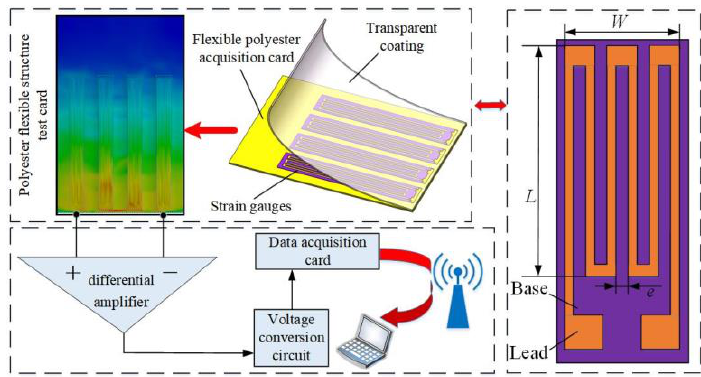
Figure 1. Schematic diagram of real-time detection device system for an unmanned aerial vehicle (UAV). Note: W is the width of the grating wire; L is the length of the grating wire; e is the spacing of the grating wire.